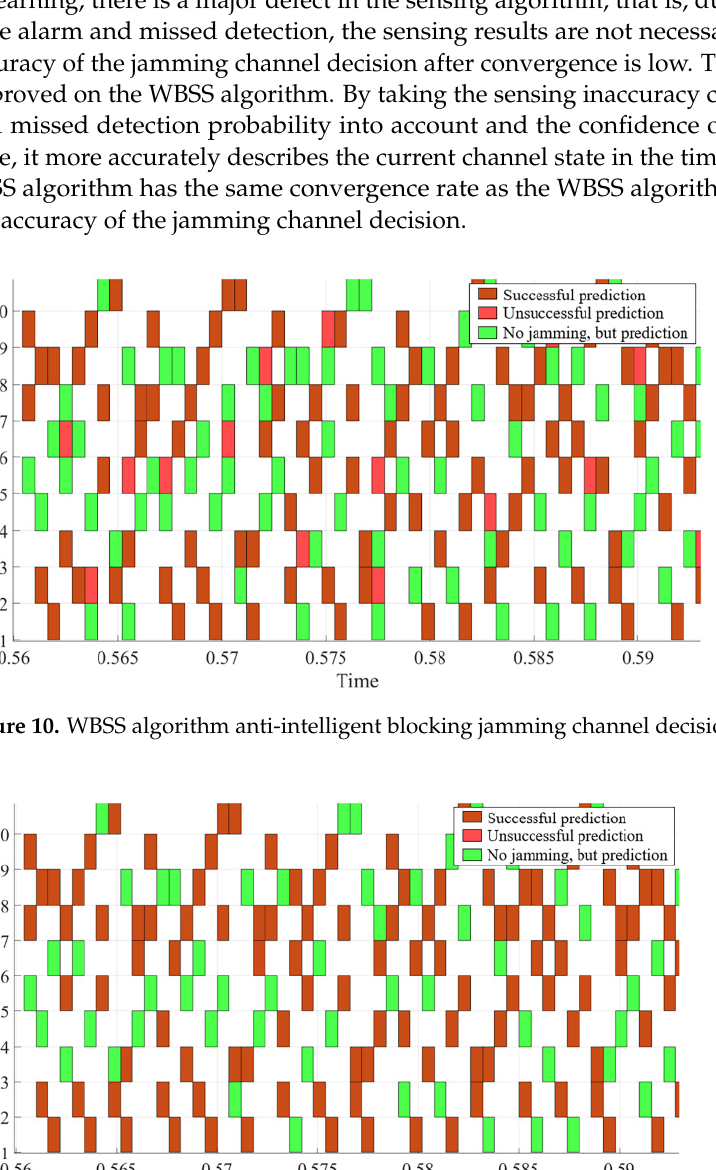
Figure 11. NISS algorithm anti-intelligent blocking jamming channel decision diagram.